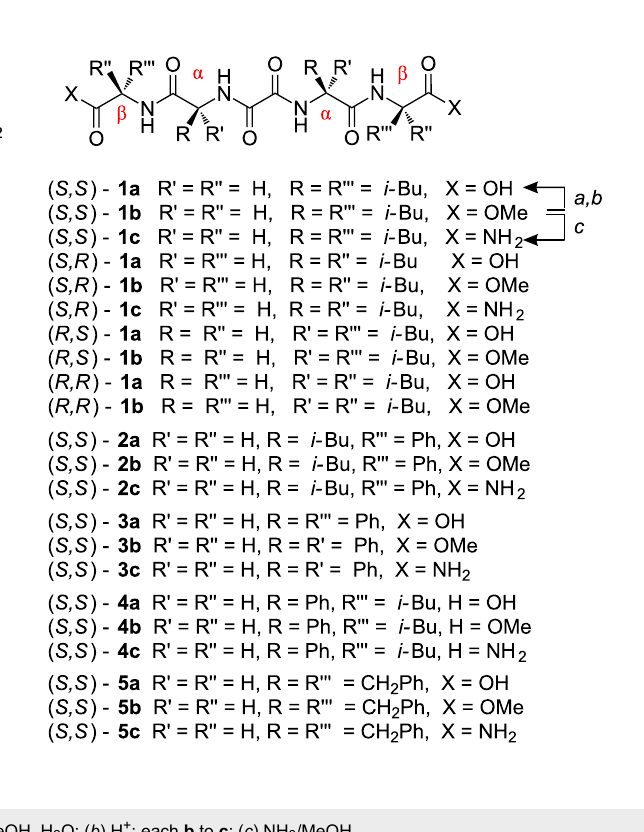
The influence of stereochemistry on self-aggregation and morphology was studied with 1a–c combining different config- urations of Leu: ( S,R )- 1a , b , c and ( R,S )- 1a , b , c . Gelation prop- erties of pure enantiomers ( S,S )- 1b and ( S,R )- 1b are compared with those of ( S,S )- 1b /(R,R)- 1b and ( S,R )- 1b /( R,S )- 1b racemic mixtures (Scheme